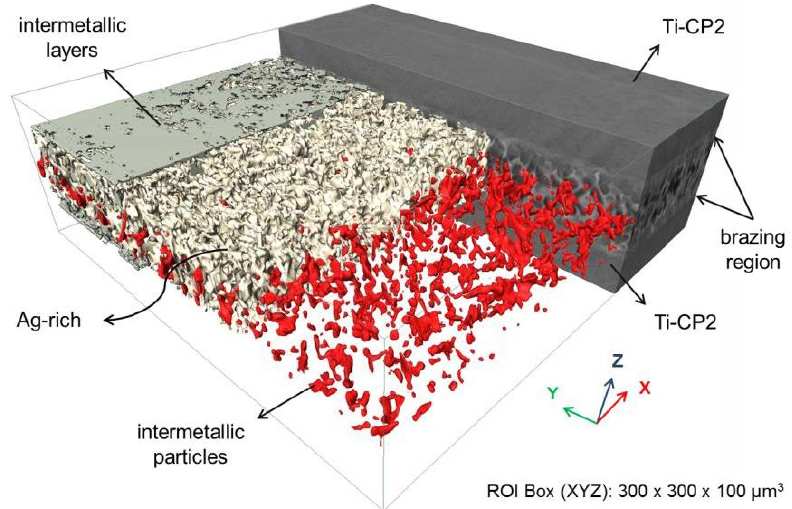
Figure 3. 3D distribution of microstructural constituents in the brazing region of the Ti-CP2/Ag28Cu system obtained by SXCT. The cuboid (grey-scale) in the back shows a brazing region between two Ti-CP2 parts while in the front the constituents are presented separately: Intermetallic layers, Ag-rich region and intermetallic particles inside the Ag-rich region.